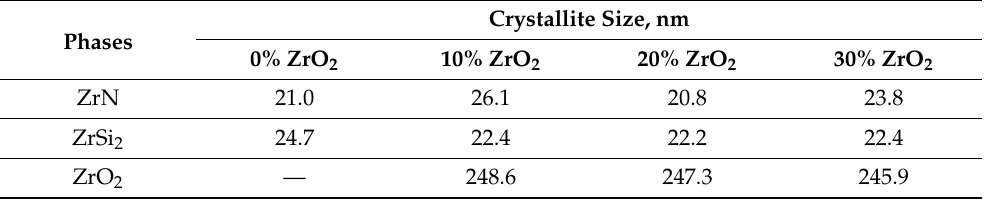
Table 1. Crystallite sizes of different phases calculated from the samples’ XRD diagrams.